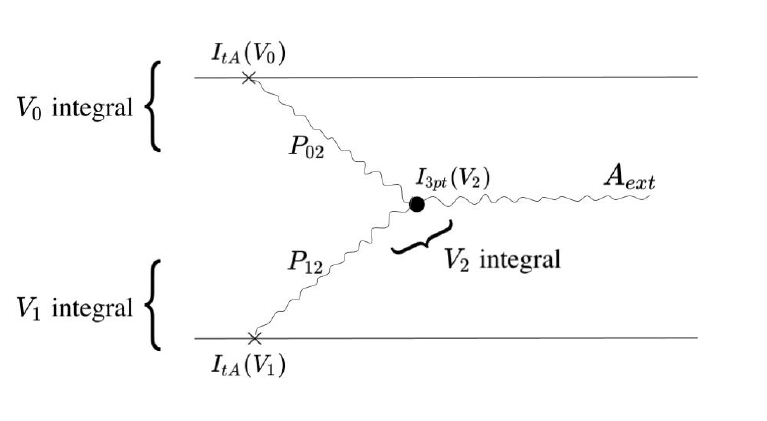
Figure 8: The 1-loop Feynman diagram associated with the A → A ⊗ A coproduct. All the ingredients are explicitly